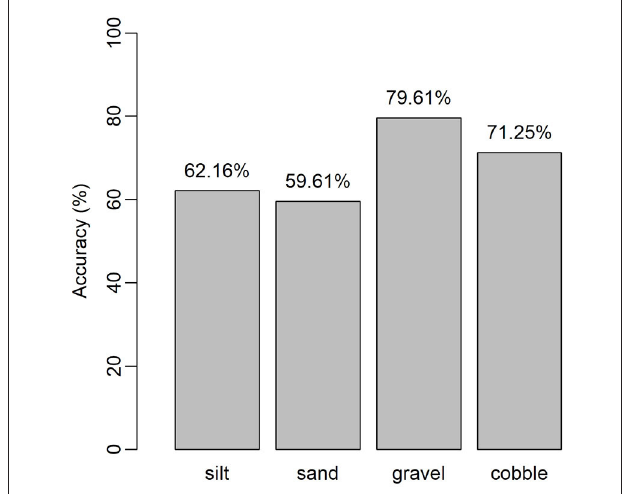
FIGURE 5 | RF prediction accuracy for the four lumped groups: silt, sand, gravel, and cobble.